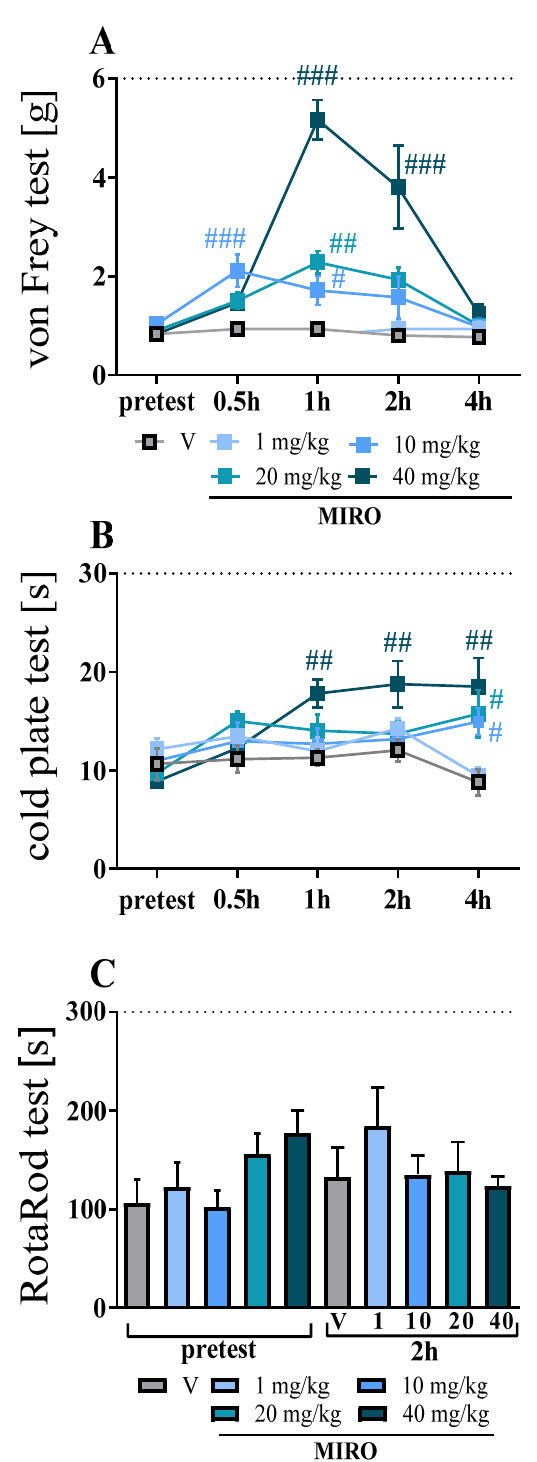
Figure 1. Effect of single intraperitoneal ( i.p .) administration of mirogabalin (1, 10, 20, 40 mg/kg) on pain-related behaviours in mice on day 11 post-CCI (von Frey test— A ; cold plate test— B ; rotarod test— C ). The horizontal dotted line represents the cut-off value. The data are presented as the means ± SEM (6–7 mice per group). Intergroup differences were analysed based on one-way ANOVA with Bonferroni’s multiple comparisons post hoc test. # p < 0.05, ## p < 0.01, ### p < 0.001 indicate a significant difference between V-treated and mirogabalin-treated CCI-exposed animals. Additionally, the results were evaluated using two-way ANOVA to determine the time × drug interaction (please see results in Section 2.1). Abbreviations: MIRO—mirogabalin;